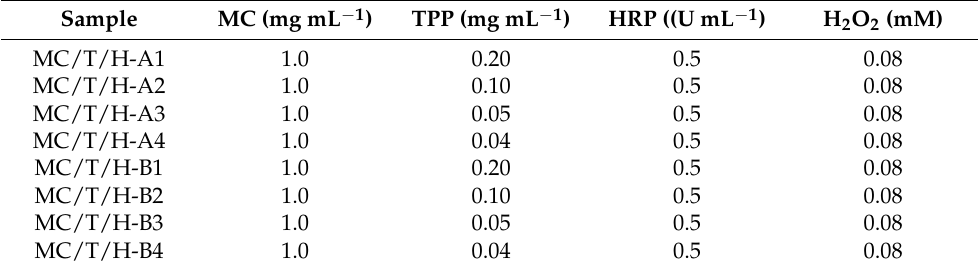
Table 1. Composition of multiple-crosslinked nanogels with TPP and HRP.